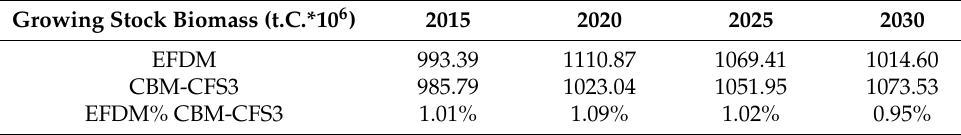
Table 4. Comparison of levels of growing stock biomass (t.C.*10 6 ).